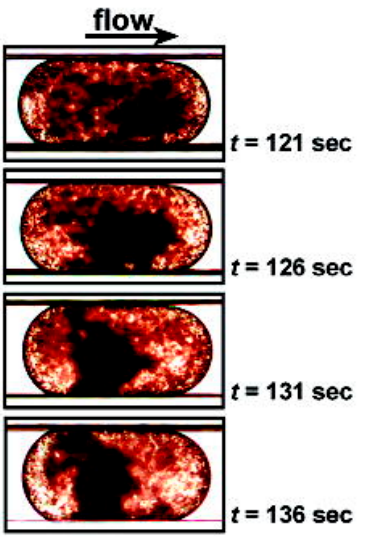
Figure 8. Bright-field microscopic image analysis of a single plug representing the formation of the clot through a dark spot with respect to time. Taken with permission from [32].